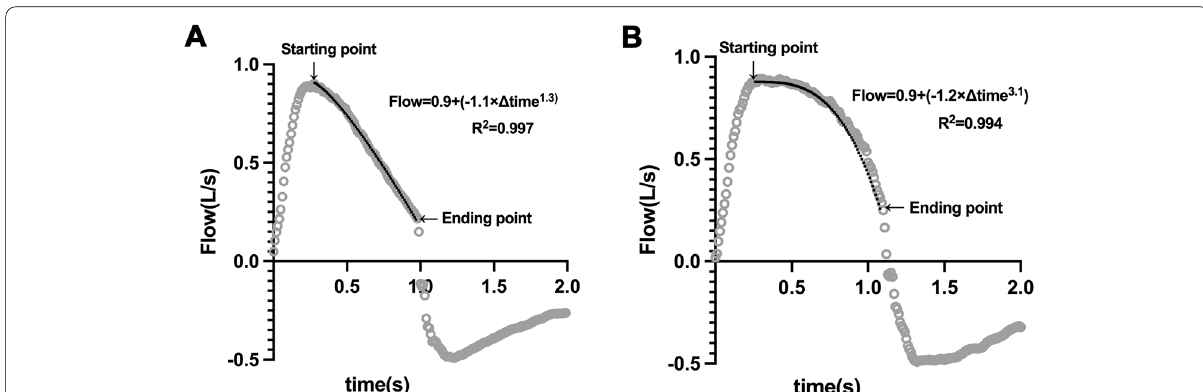
Fig. 1 Schematic show of flow index measurement. Flow–time waveform (grey circle, 100 Hz) for a single breath under pressure support ventilation is shown. The starting point of flow–time fitting was defined as the flow increased less than 1% of the preceding measurement, and the ending point was identified as the flow decreased more than 10% of the former measurement. The equation of fitting is also shown. The solid black line indicates the flow–time fitting curve ( R 2 0.997 and 0.994). The flow index was 1.3 and 3.1 in panel A and panel B, =